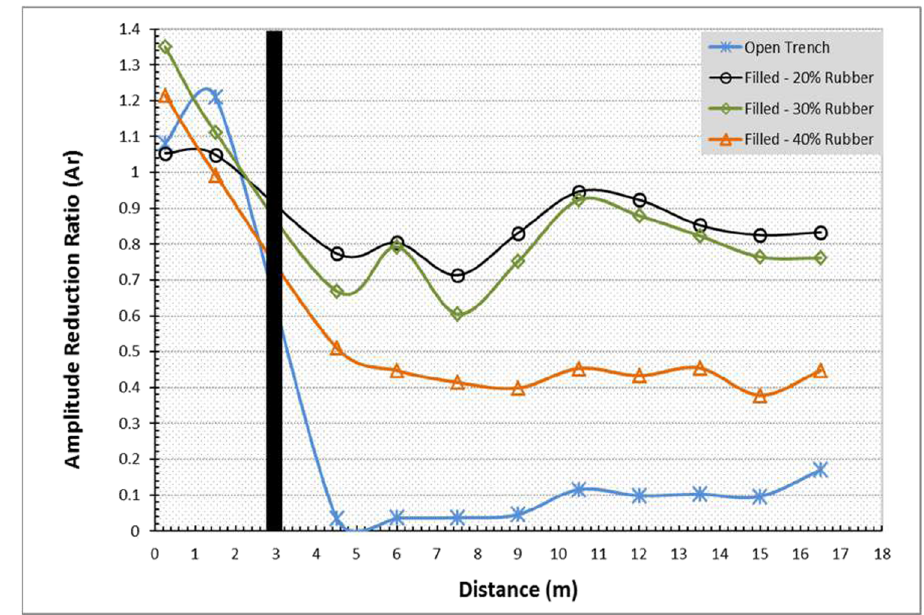
Figure 15: Attenuation of vibration due to active trench barriers ( f 40 Hz = )